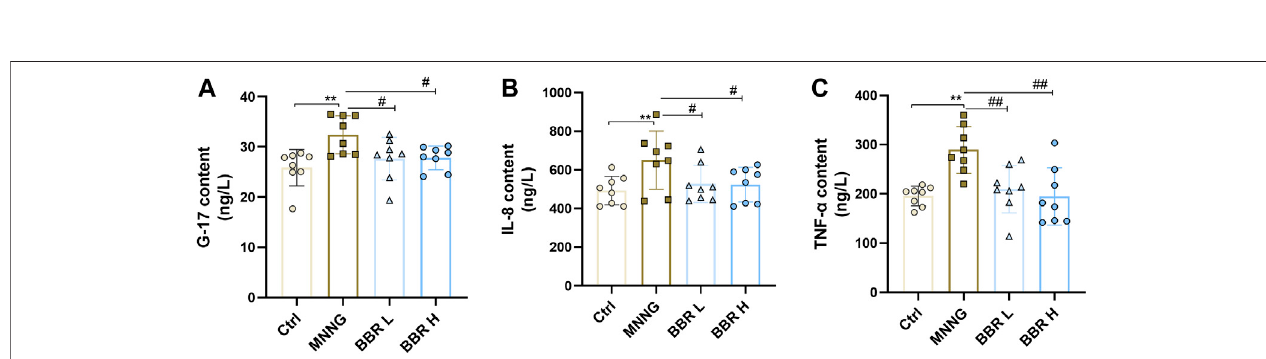
FIGURE 5 | Detection of G-17, IL-8 and TNF- α expression in serum of CAG rats by ELISA kit. Data were shown as mean ± SD ( N (cid:1) 8). ** < 0.01 vs. control group. ## < 0.01 vs. MNNG group; # < 0.05 vs. MNNG group. Ctrl, Control; BBR L, BBR low dose group; BBR H, BBR high dose group.